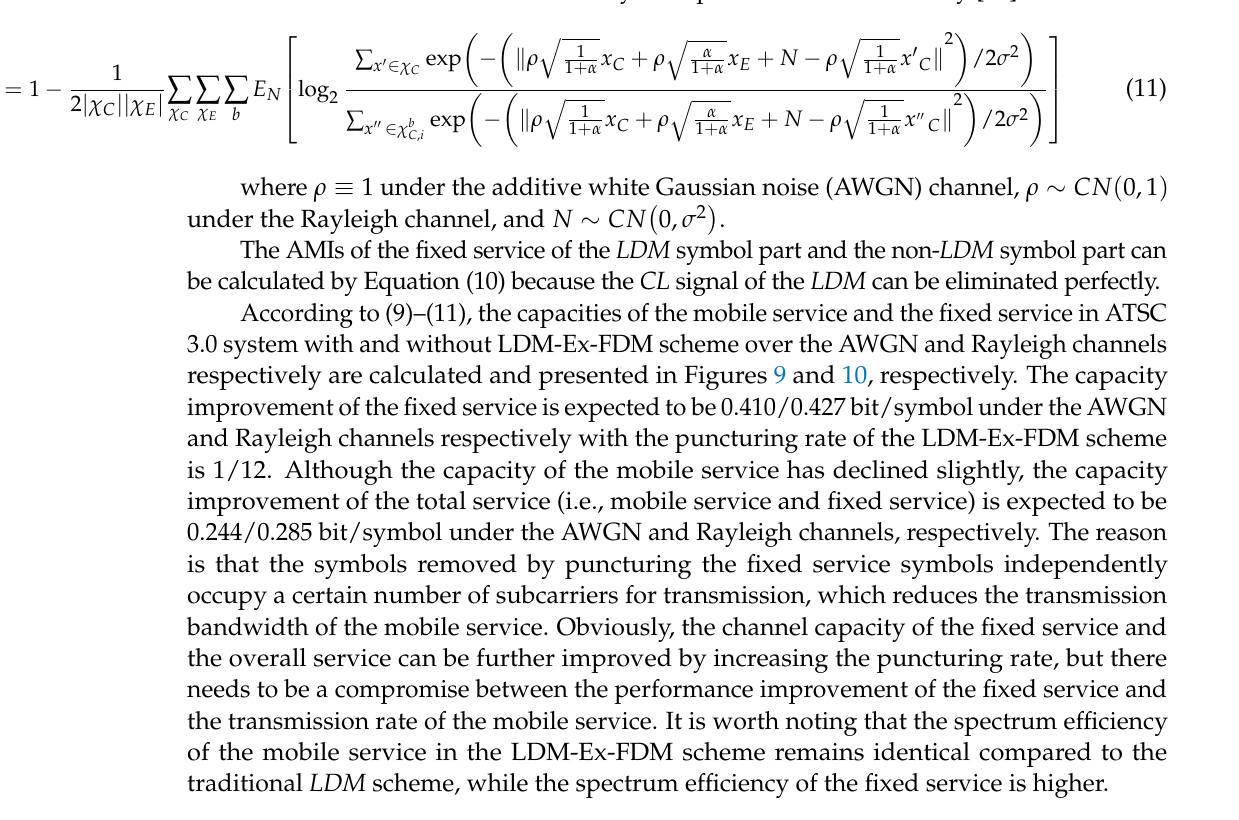
Figure 10. Capacities of mobile service and fixed service in ATSC 3.0 system with and without LDM-Ex-FDM scheme over the Rayleigh channel, where the parameter of ATSC 3.0 system was set to  = 10 dB, the CL constellation was set to QPSK, the EL constellation was set to NU−64QAM, and the puncturing rate of the LDM -Ex-FDM scheme was set to 1/12. 4. Simulation Results and Analysis 4.1. Simulation Setup and Parameters In this section, the BER performance of the traditional LDM scheme was evaluated by physical layer simulations. The transceiver chain complied with the ATSC 3.0 specifi- cation [21]. The traditional SIC detector with a minimum mean square error (MMSE) equalizer was used to evaluate performance. Two symbol puncturing algorithms and the DIC detector described in Section 3 were implemented. The scattered pilot (SP) scheme